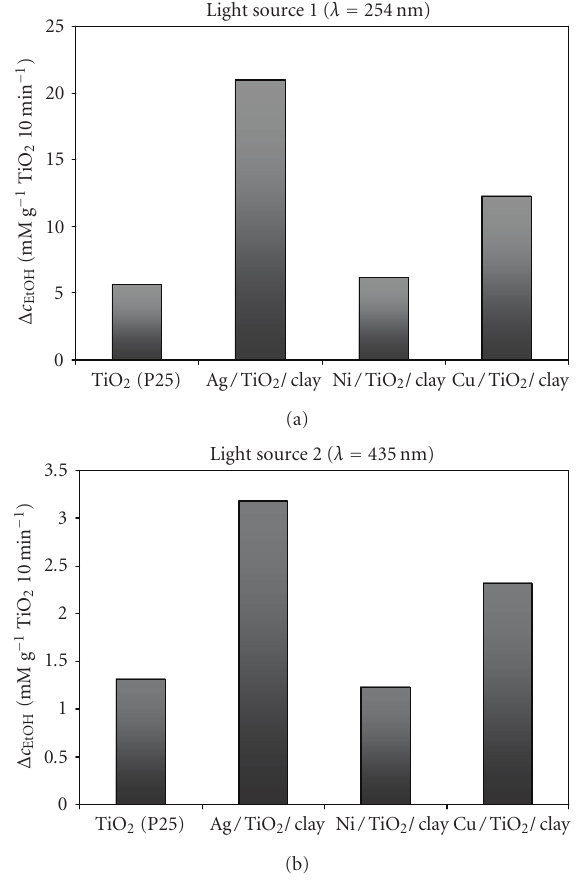
Figure 6: Amount of degraded ethanol in unit time (1 minute), normalized to a catalyst film surface of 1m 2 ( w ).